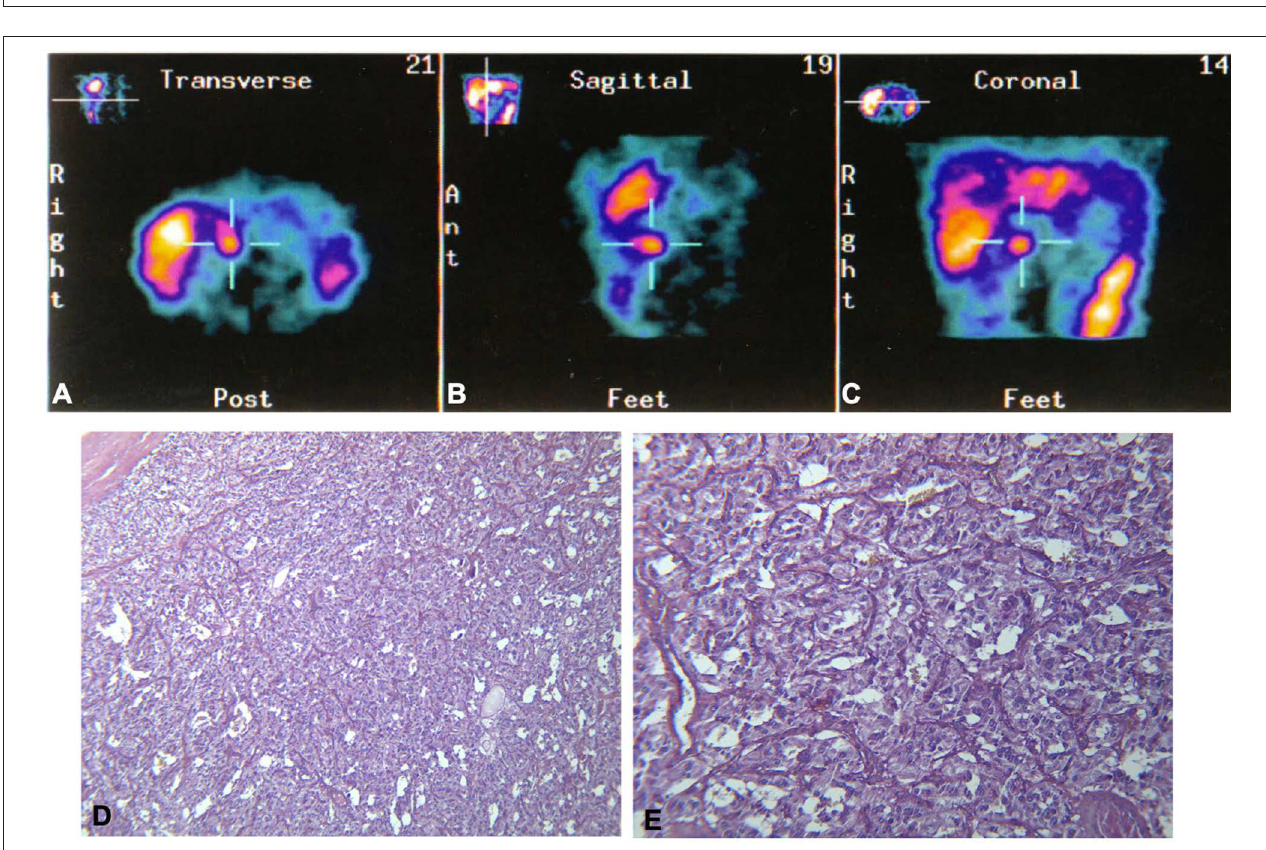
FIGURE 3 | Top: 131 I-metaiodobenzylguanidine (MIBG) scintigraphy distinctly shows a hot spot in the inter-aortocaval region, as seen in the (A) transverse, (B) sagittal, and (C) coronal scans. Bottom: Histological appearance of the paraganglioma, cords and nests of cellular elements with abundant granular basophilic cytoplasm and ovoid nuclei with prominent nucleoli. (D) EE 10 × . (E) EE 20 × .